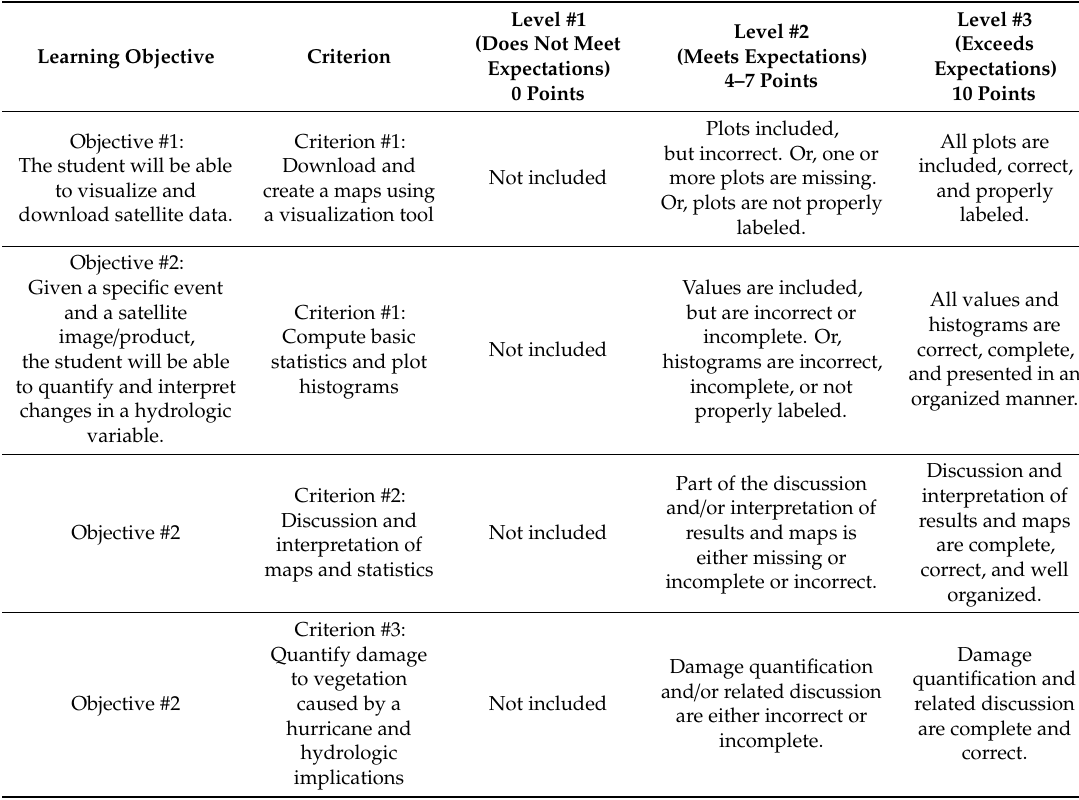
Table 3. Rubric of the learning activity in the Spatial Dimension of Satellite Data section (Section 3) of the Remote Sensing Applications in Hydrology